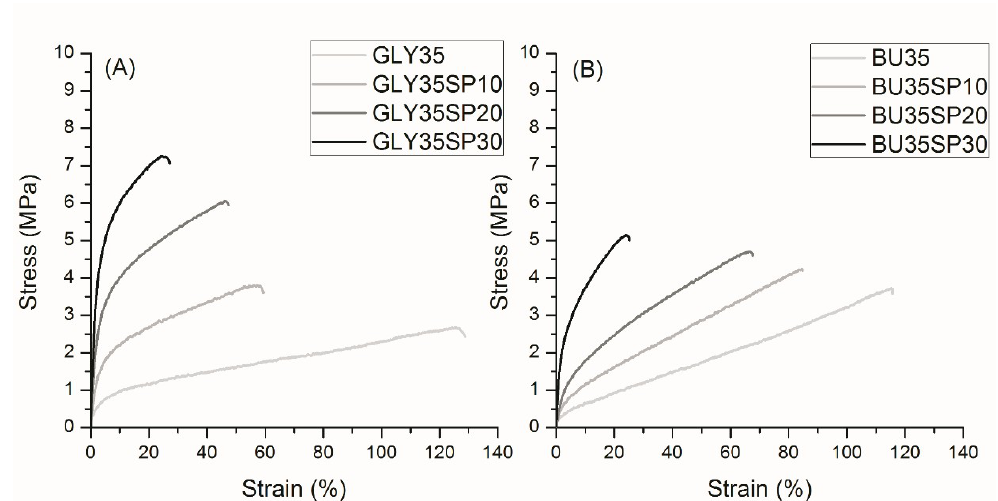
Figure 2. Stress–strain curves of gluten samples plasticized with glycerol ( A ) and 1,4-butanediol ( B ) with 0, 10, 20, and 30 php of microalgal ( Spirulina platensis ) biomass. Table 1. Elastic modulus (E t ), elongation at break (ε b ), stress at break (σ b ), and toughness values of samples plasticized with 35% glycerol and 1,4-butanediol, with 0, 10, 20, and 30 php of microalgal biomass.